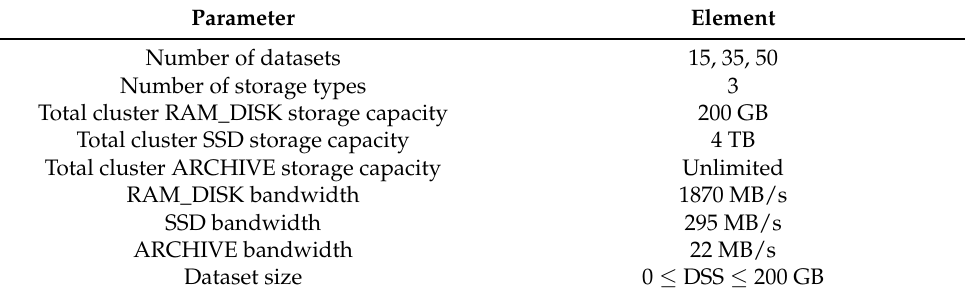
Table 5. Experimental setup.